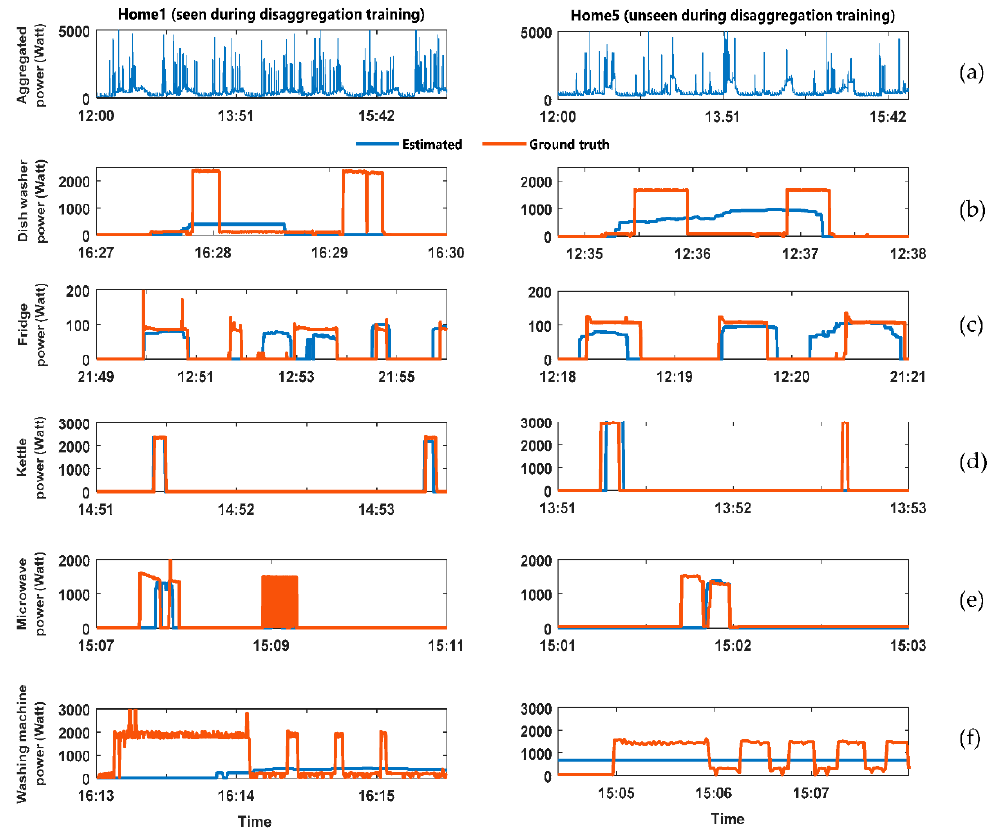
Figure 5. Shows the energy disaggregation algorithm output by using RECTANGLES technique. ( a ) Aggregated power consumption for the home; ( b ) wish washer estimated and Ground truth power demand; ( c ) fridge estimated and Ground truth power demand; ( d ) kettle estimated and Ground truth power demand; ( e ) microwave estimated and Ground truth power demand; ( f ) Washing machine estimated and Ground truth power